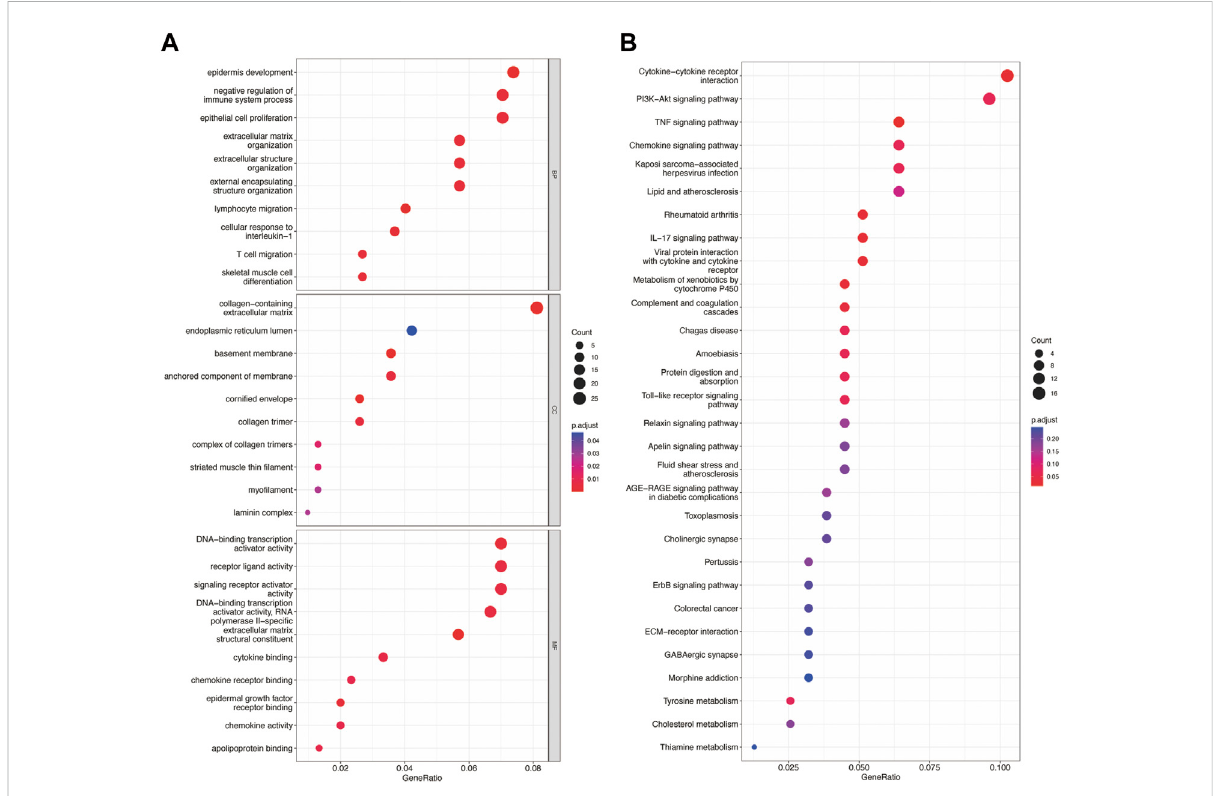
FIGURE 4 GO and KEGG enrichment of differential expression of mRNA. (A) The top 10 enrichment of BP, CC, and MF of differential expression of mRNA. (B) The top 30 enrichment of KEGG of differential expression of